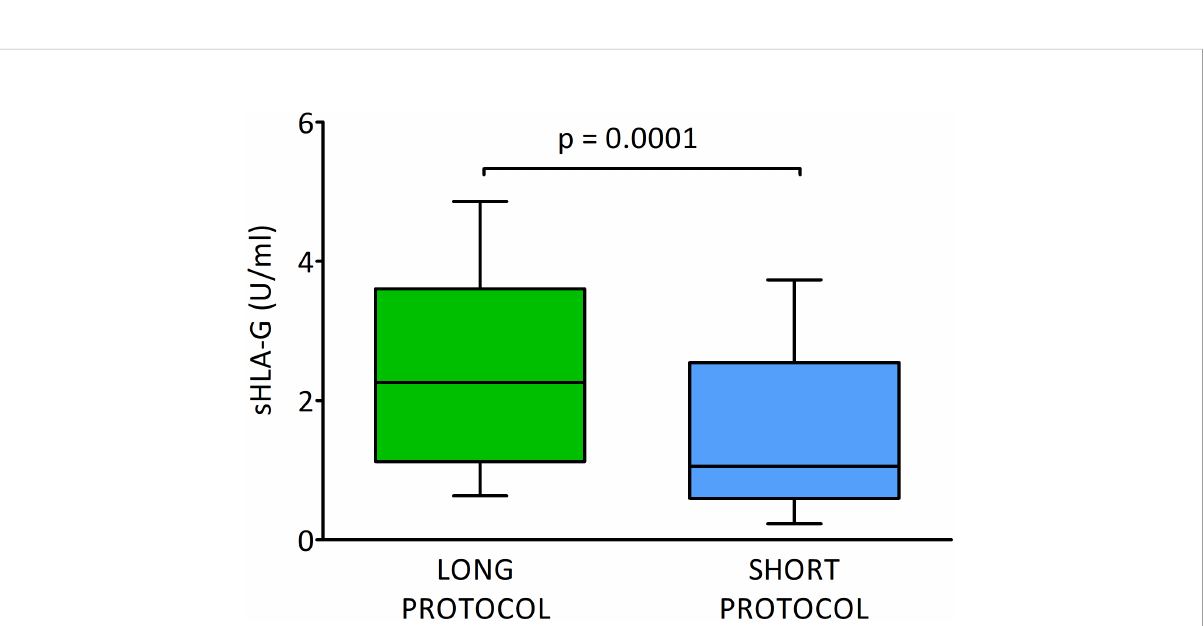
FIGURE 2 Secretion of soluble HLA-G (U/ml) by embryos in different ovarian stimulation protocols. Green box represents the level of sHLA-G measured in embryo media in long cycle, blue box – in short cycle. Boxes are drawn from the fi rst quartile (25 th percentile) to the third quartile (75 th percentile). Black lines in boxes are medians. Whiskers represent 10-90 percentiles. P-values are calculated by Mann-Whitney test.